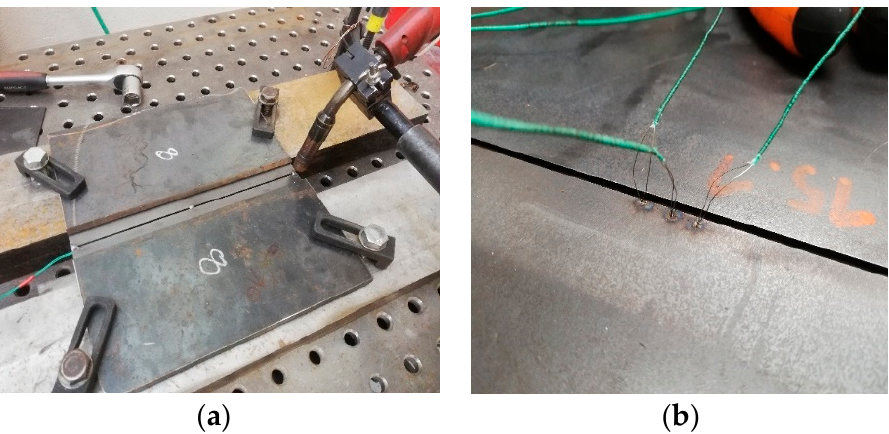
Figure 1. ( a ) Tackled plates fixed before welding and ( b ) thermocouples at the root side of the weld.